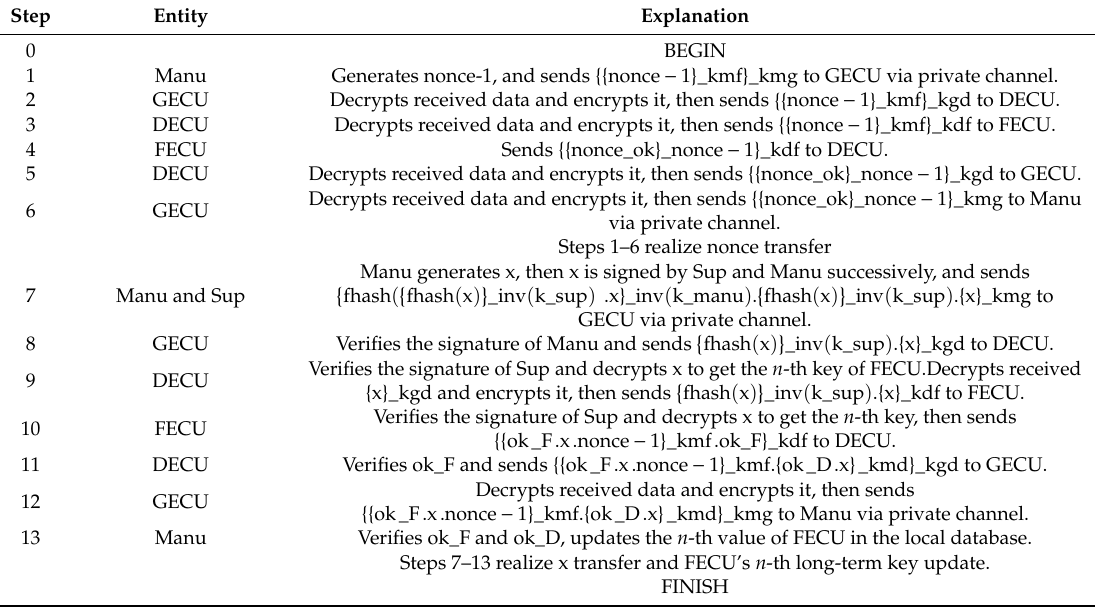
Table 5. Explanation of OTA-based long-term key update procedure.